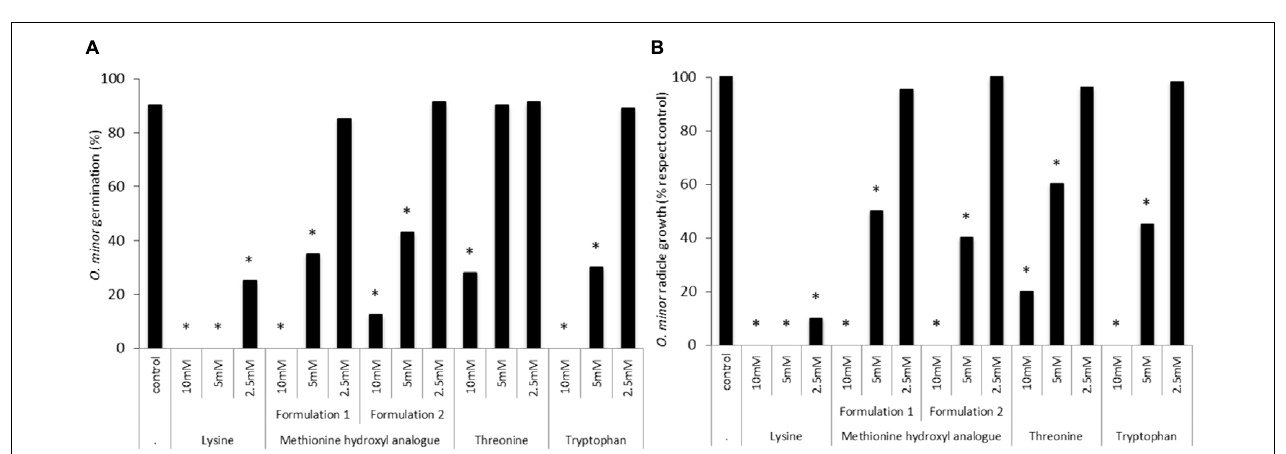
FIGURE 4 | Effects of lysine-, methionine hydroxyl analog-, threonine-, and tryptophan-based feed supplements in O. minor in vitro development. (A) Inhibition of O. minor germination. (B) Inhibition of O. minor radicle growth. ∗ Indicates differences of each treatment compared with the control (2.5 mM methionine treatment) assessed by Dunnett’s test at the 0.05